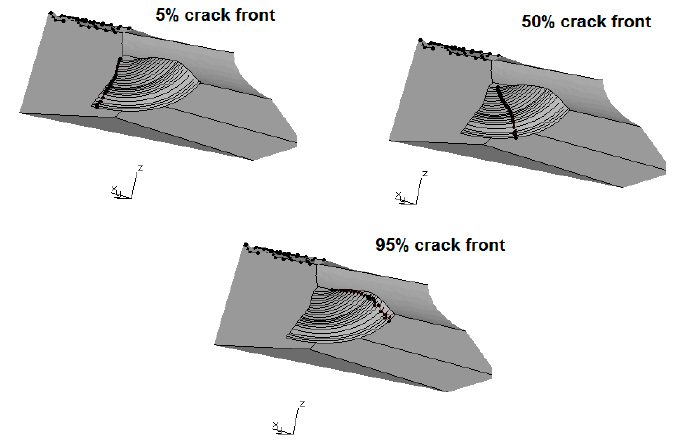
Figure 10. Three crack paths where the stress intensity was computed.